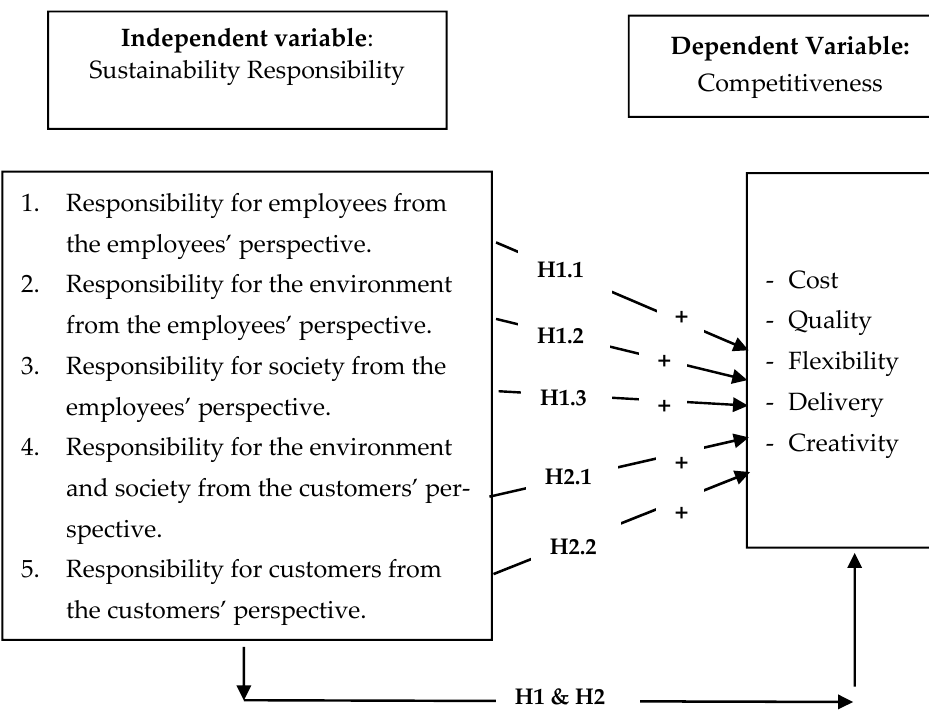
Figure 1. Research variables and hypotheses.